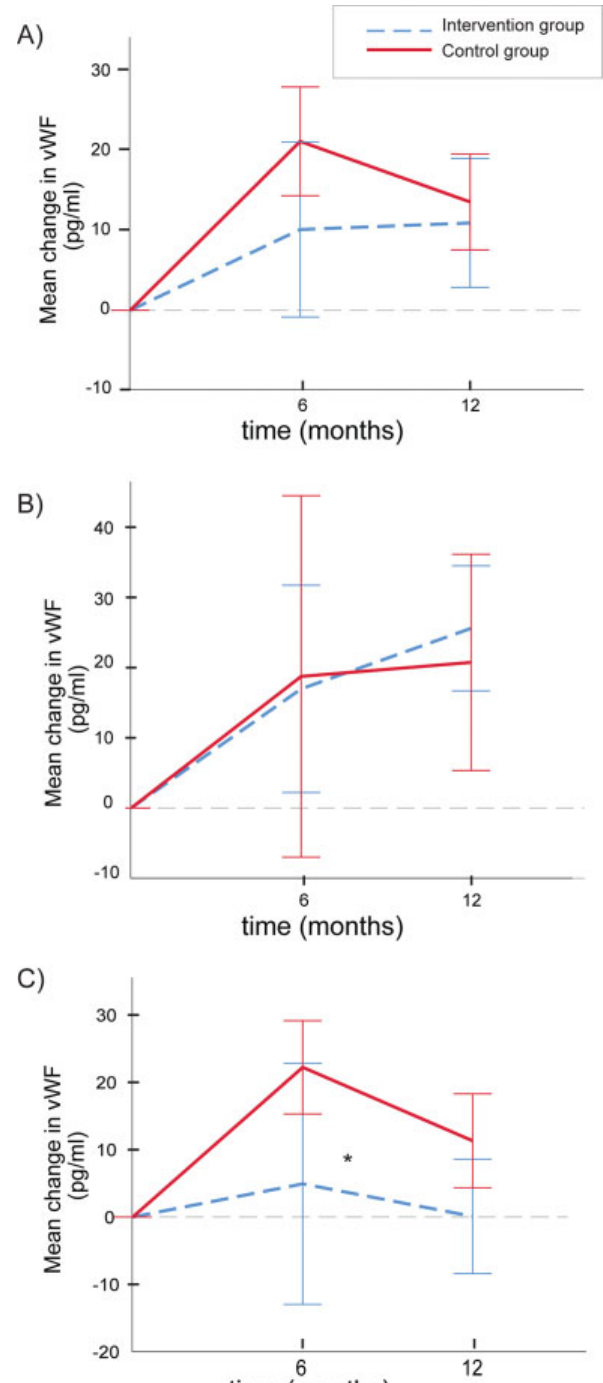
Fig. 3 Concentrations of von Willebrand factor in the two study groups duringthe1-yearobservationperiod.Thelinesshowmean(95%con fi dence intervals)differencesfrombaselineintheinterventiongroup(bluestippled lines)andthecontrolgroup(redlines)at6and12months.Dataareshown for the total patient group ( A ), the premenopausal ( B ), and the postmen- opausal women ( C ). The asterisk denotes a signi fi cant difference between the two study groups with regard to main group effect (mixed model adjusting for baseline values, (cid:6) p ¼ 0.026). The ratios of the number of pre- and postmenopausal women in the control group at time points 0, 6 and 12 months were 5/16, 5/14, and 5/15, respectively. The corresponding ratios of pre- and postmenopausal women in the intervention group were 9/12, 7/9, and